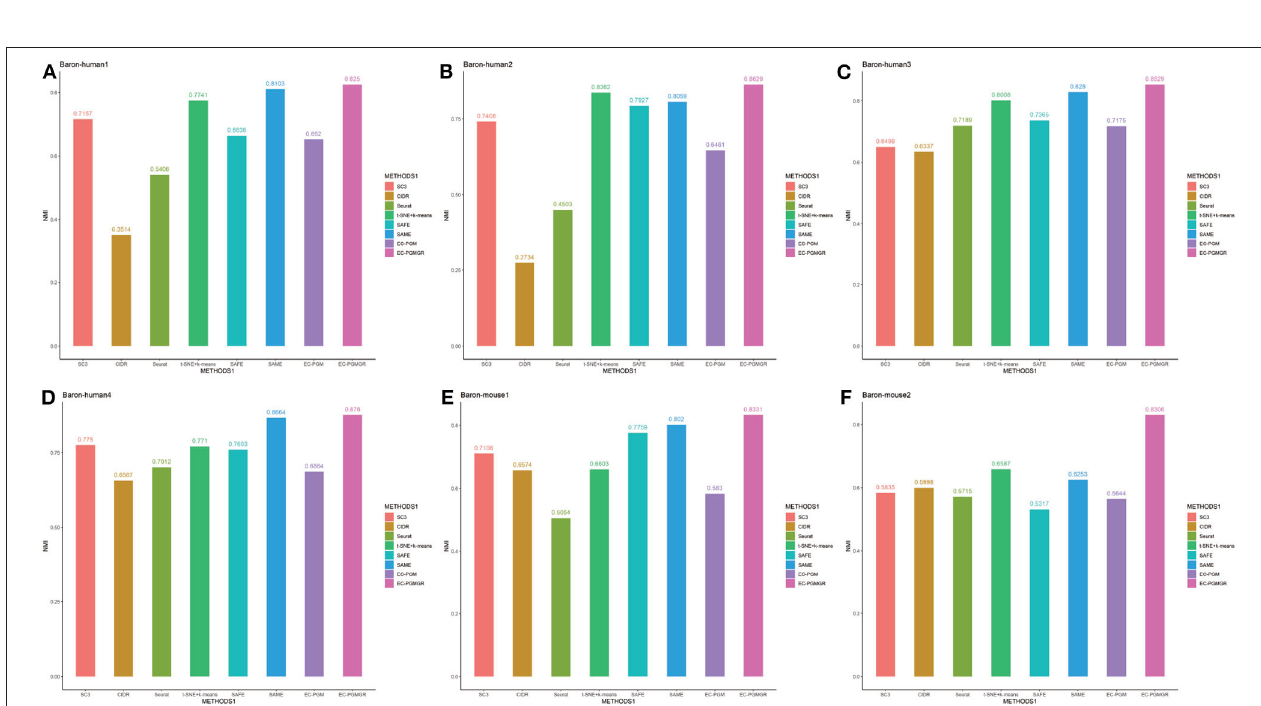
FIGURE 5 | Performance on different data sets with different methods in terms of ARI. SC3, CIDR, Seurat and t-SNE+k-means are the individual methods, while SAFE, SAME, EC-PGM and EC-PGMGR are the ensemble clustering methods. (A) Baron-human1. (B) Baron-human2. (C) Baron-human3. (D) Baron-human4. (E) Baron-mouse1. (F) Baron-mouse2.